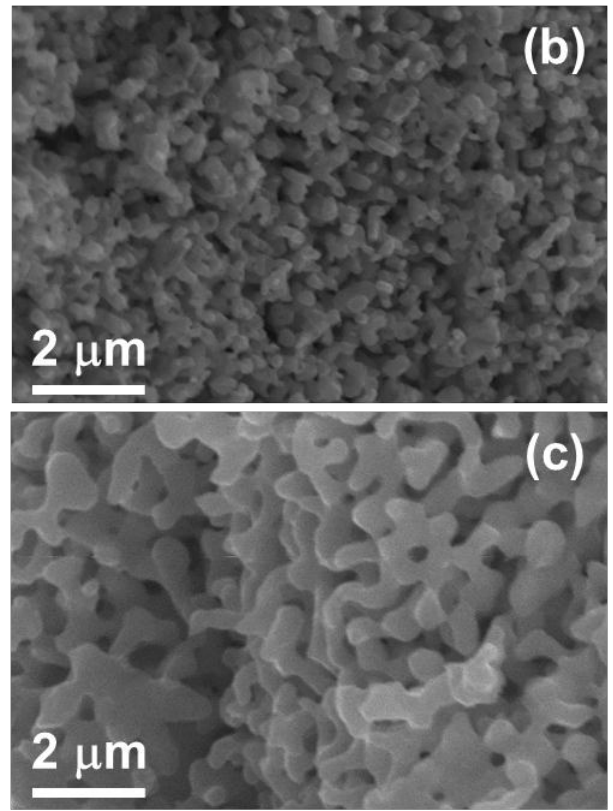
Figure 8. Secondary electrons images of the inner porous region in the reduced metallic microtubes: ( a ) Cu-65Ni; ( b ) Cu-44Ni; ( c ) Cu-23Ni.